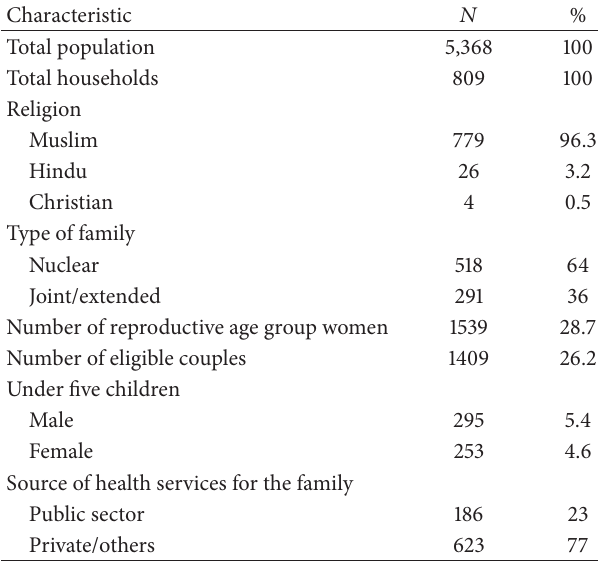
Table 1: Key sociodemographic characteristics of the study popula- tion.